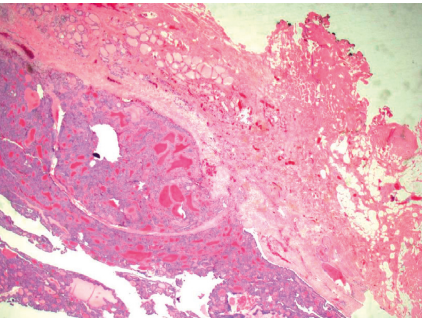
Figure 2: H&E stain at 4x magnification of anterior neck mass demonstrating epithelial capsule without cilia surrounding papil- lary architecture and few normal thyroid components. No evidence of cystic components is seen. The histological stain shows that the anterior neck mass is consistent with an ectopic papillary thyroid